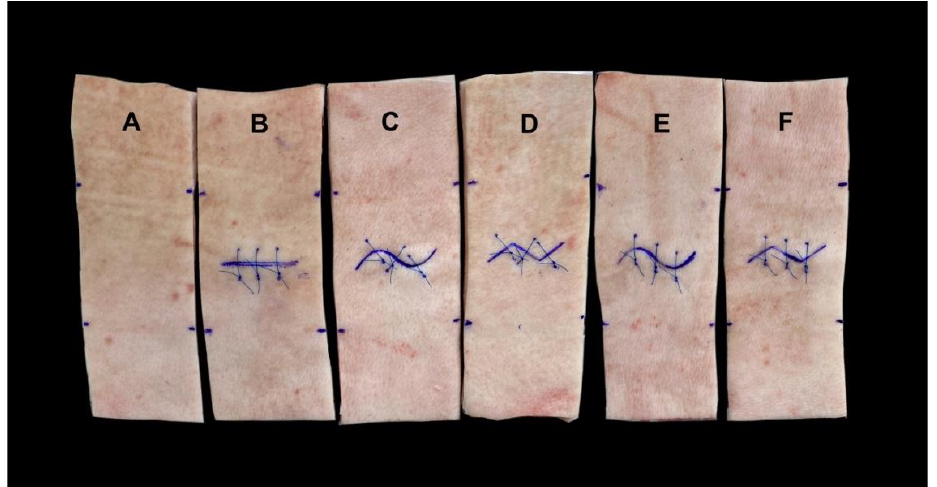
Figure 1. Examples of skin samples used for each experimental group. Control ( A ), conventional straight incision pattern ( B ), Lazy-S ( C ) and Zigzag ( D ) incision patterns with perpendicular (90°) placement of sutures, as well as Lazy-S ( E ) and Zigzag ( F ) incision patterns with placement of sutures in tensile direction were tested for their biomechanical stability.